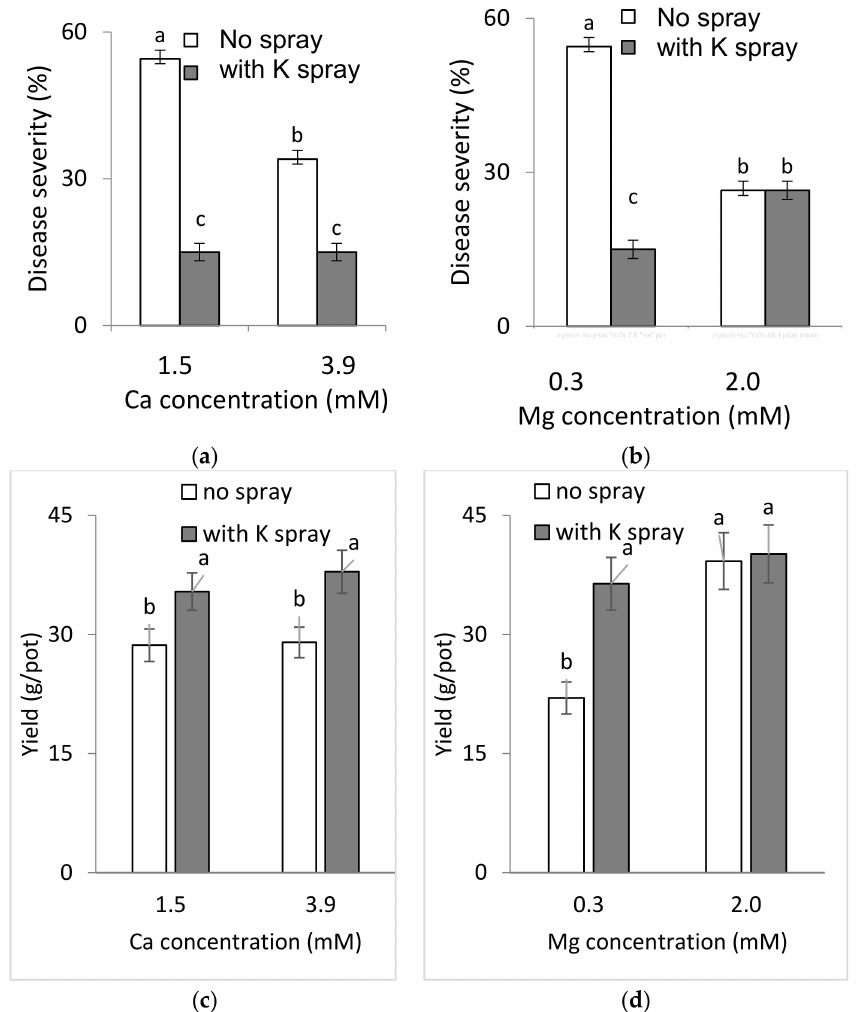
Figure 6. Effects of additional Ca ( a ) and ( c ) and Mg ( b ) and ( d ) without ( (cid:3) ) and with ( (cid:4) ) a foliar application of 1% K 2 SO 4 on the severity of sweet basil downy mildew (SBDM; a and b) and shoot yield ( c , d ). SBDM severity was evaluated on a 0–100% scale, in which 0 = healthy plants and 100% = plants completely covered by SBDM symptoms/signs. Data derive from 3 trials ( n = 5). Values followed by a different letter are significantly different according to two-way ANOVA with Tukey’s HSD test. Default significance levels were set at α = 0.05. Bar =